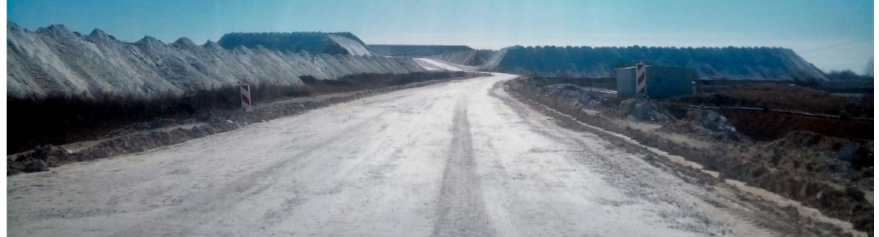
Figure 1. Stacks of phosphogypsum at a fertilizer production plant in AB Lifosa, Kedainiai, Lithuania.